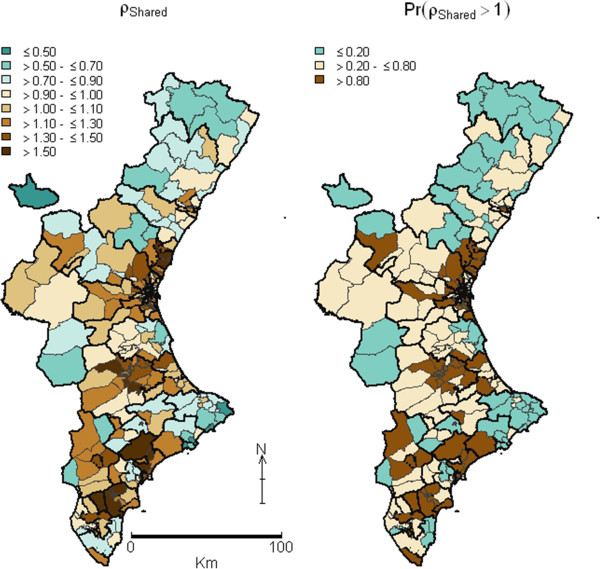
Map of the pattern shared jointly by all six PPH conditions (left) and map with posterior probabilities that shared pattern were higher than1 (right). Valencia Community, 2007–2009. Thin lines represent the boundaries between BHZ and thick lines the boundaries between Healthcare Areas. In the map of PPH shared pattern (left) colours represent relative risks regarding the jointly Valencia Community shared pattern of PPH admissions. In the map of posterior probability (right) dark-brown coloured territories are BHZ for which the probability of having a relative risk of PPH admissions (shared pattern) higher than 1 is >0.8, and green ones are BHZ for which this relative risk is below <0.2. PPH: Potentially Preventable Hospitalizations; BHZ: Basic Health Zones.